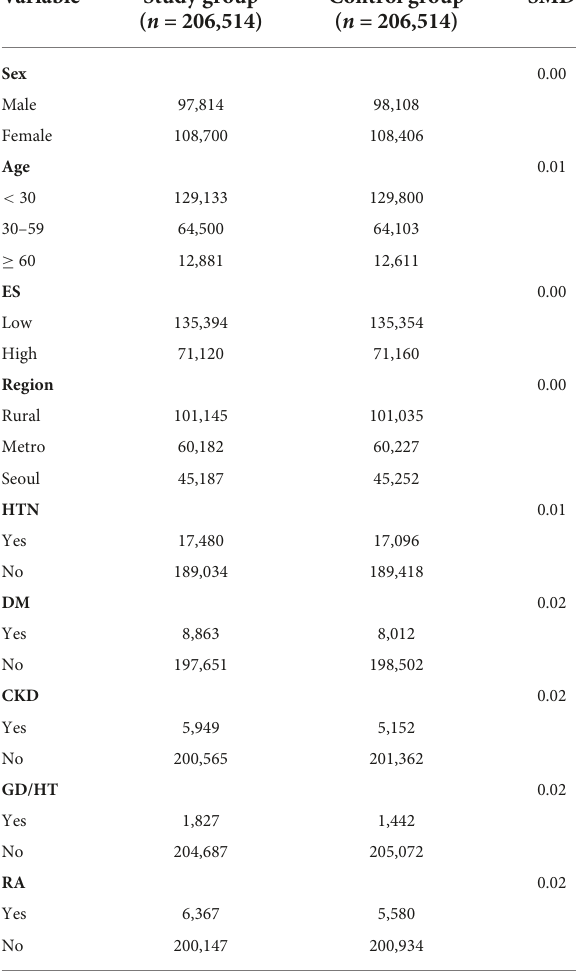
TABLE 1 Characteristics of the study (ATD) and control (non-ATD)